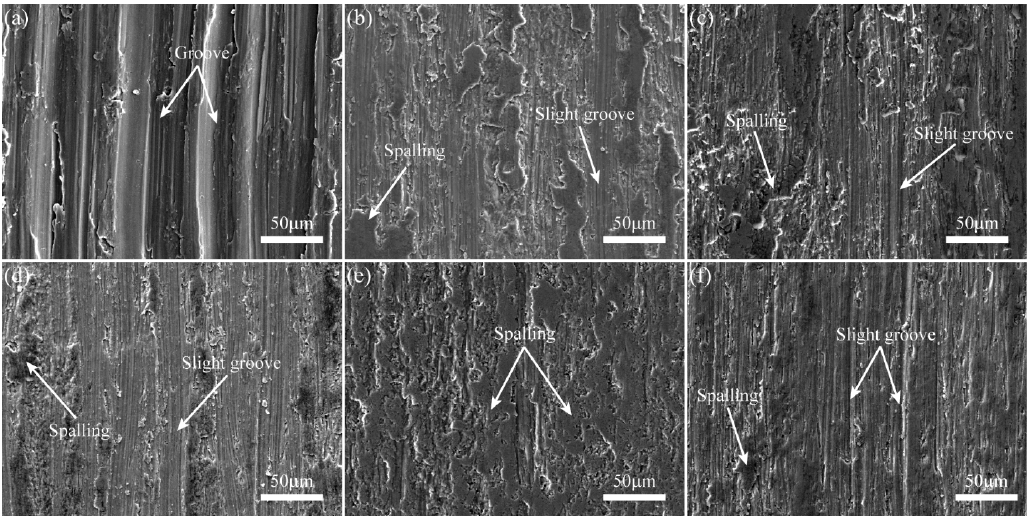
Figure 8. Typical worn surfaces of: ( a ) Ti6Al4V; ( b ) 0Ce; ( c ) 1Ce; ( d ) 3Ce; ( e ) 5Ce; ( f ) 7Ce coatings.